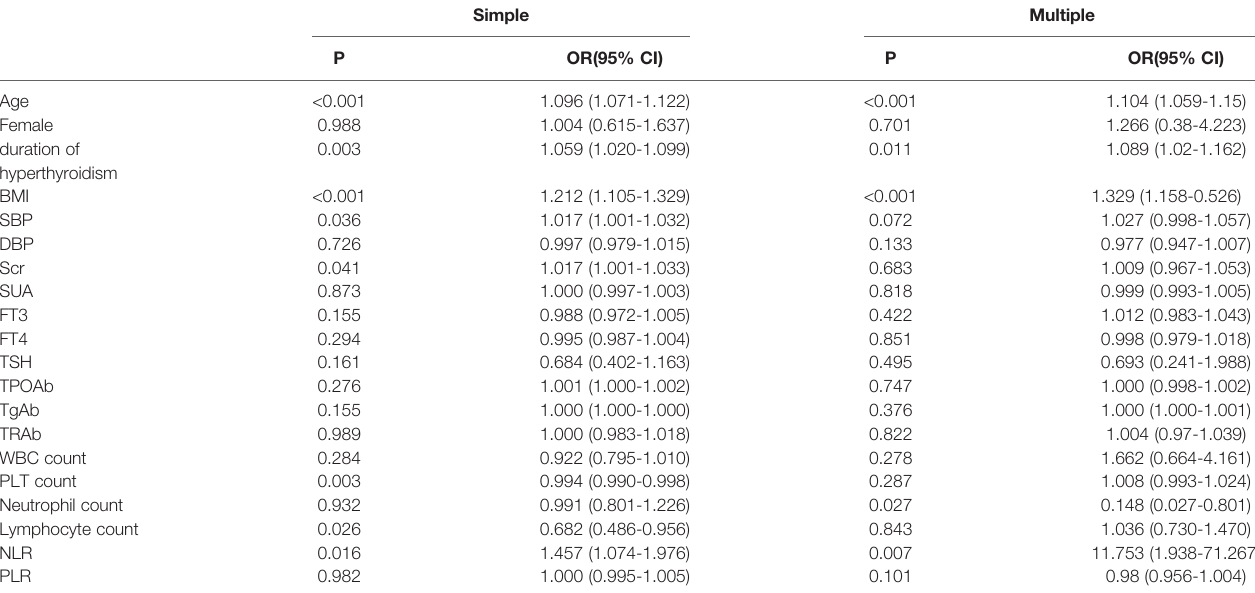
Data are presented as mean ± standard univariate and multivariate logistic regression analysis revealed that NLR was strongly correlated with LV diastolic dysfunction (OR = 1.457, 95%CI = 1.074-1.976, P = 0.016; OR=11.753, 95%CI = 1.938- 71.267, P = 0.007, respectively).